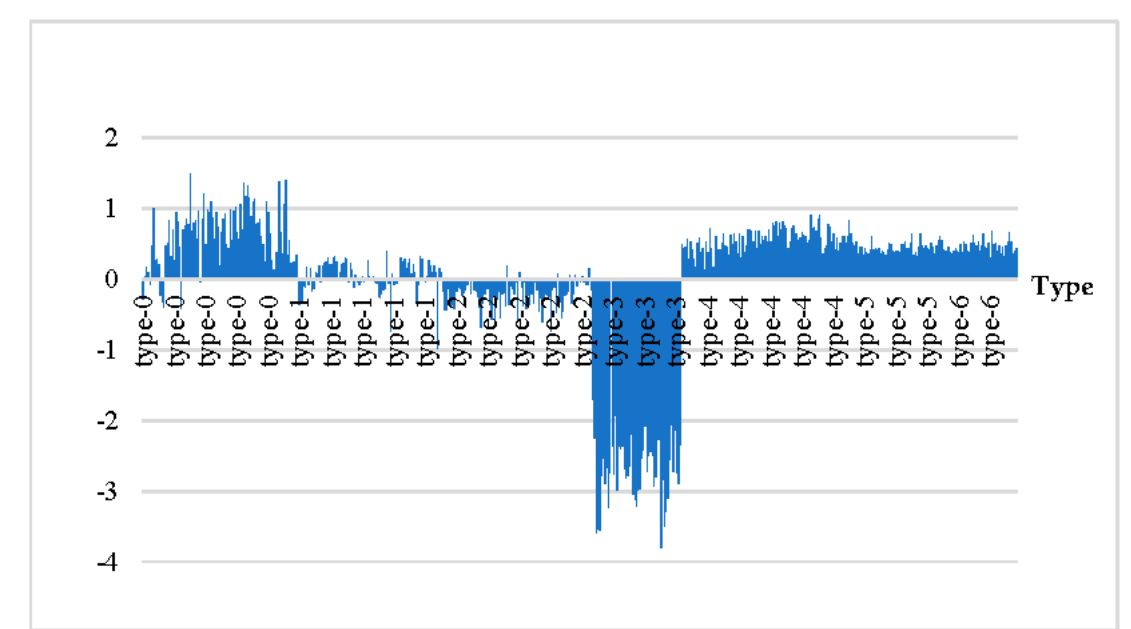
Figure 7. Texture feature in different landforms.